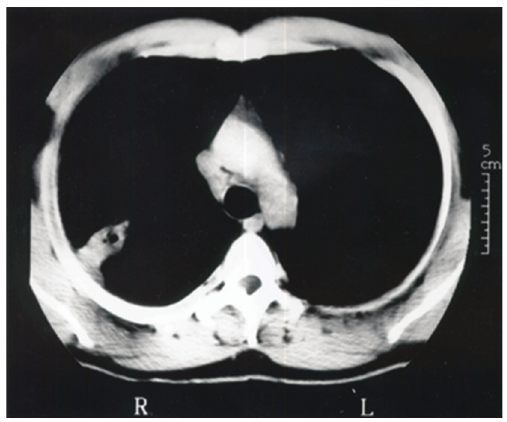
Figure 2: CT scan of the chest demonstrating the lesion in the posterior segment of the right upper lobe with central lucency.